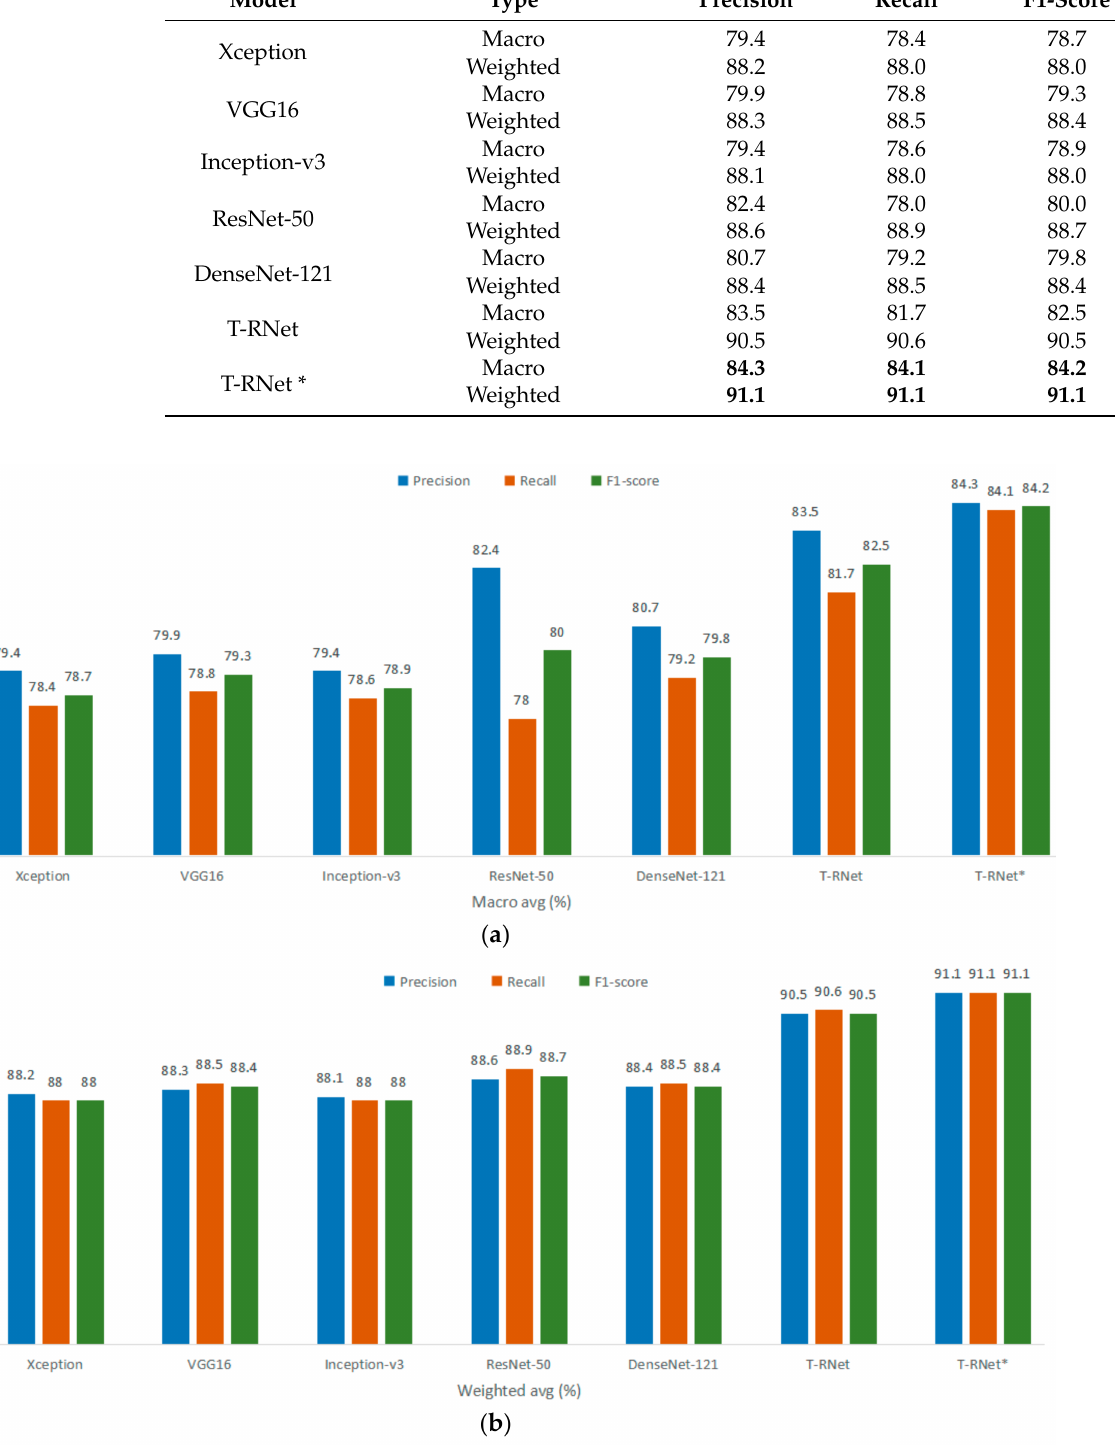
Table 4. Performances of different classification methods in terms of precision (%), recall (%), and F1-score (%). (Macro: Macro avg; Weighted: Weighted avg; T-RNet * indicates the combination of T-RNet and FAMP-Softmax loss; bold: the highest values). Model Type